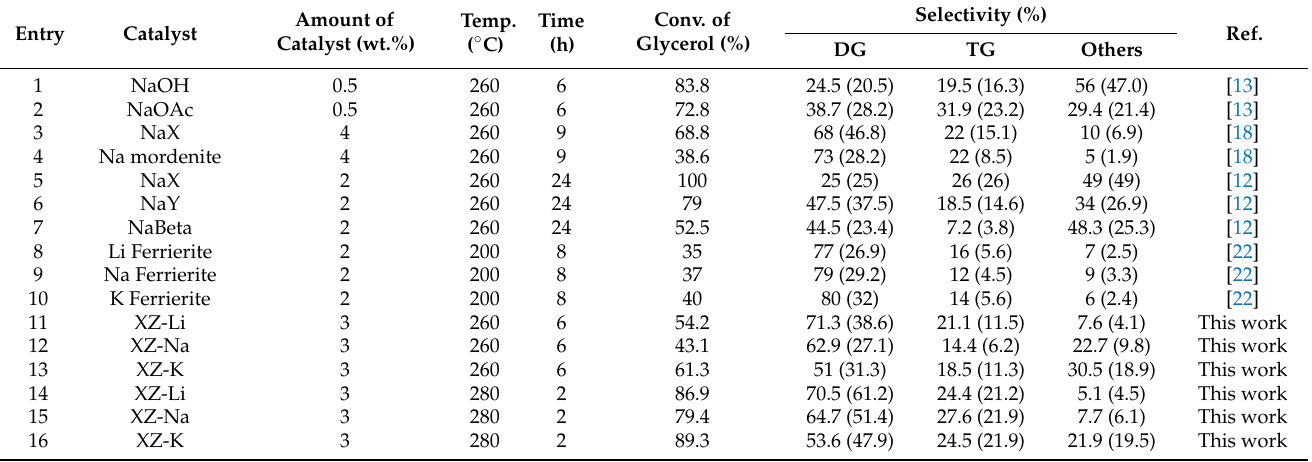
Table 1. Comparison of the catalytic activity of alkali metal cation containing catalysts in the etherification reaction of glycerol 1